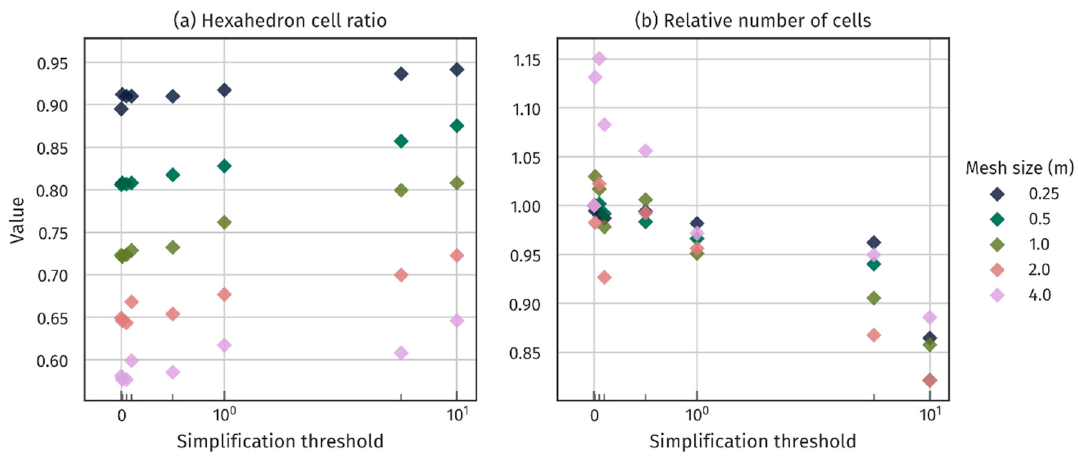
Figure 9. Statistical features of mesh according to simplification threshold and mesh size.